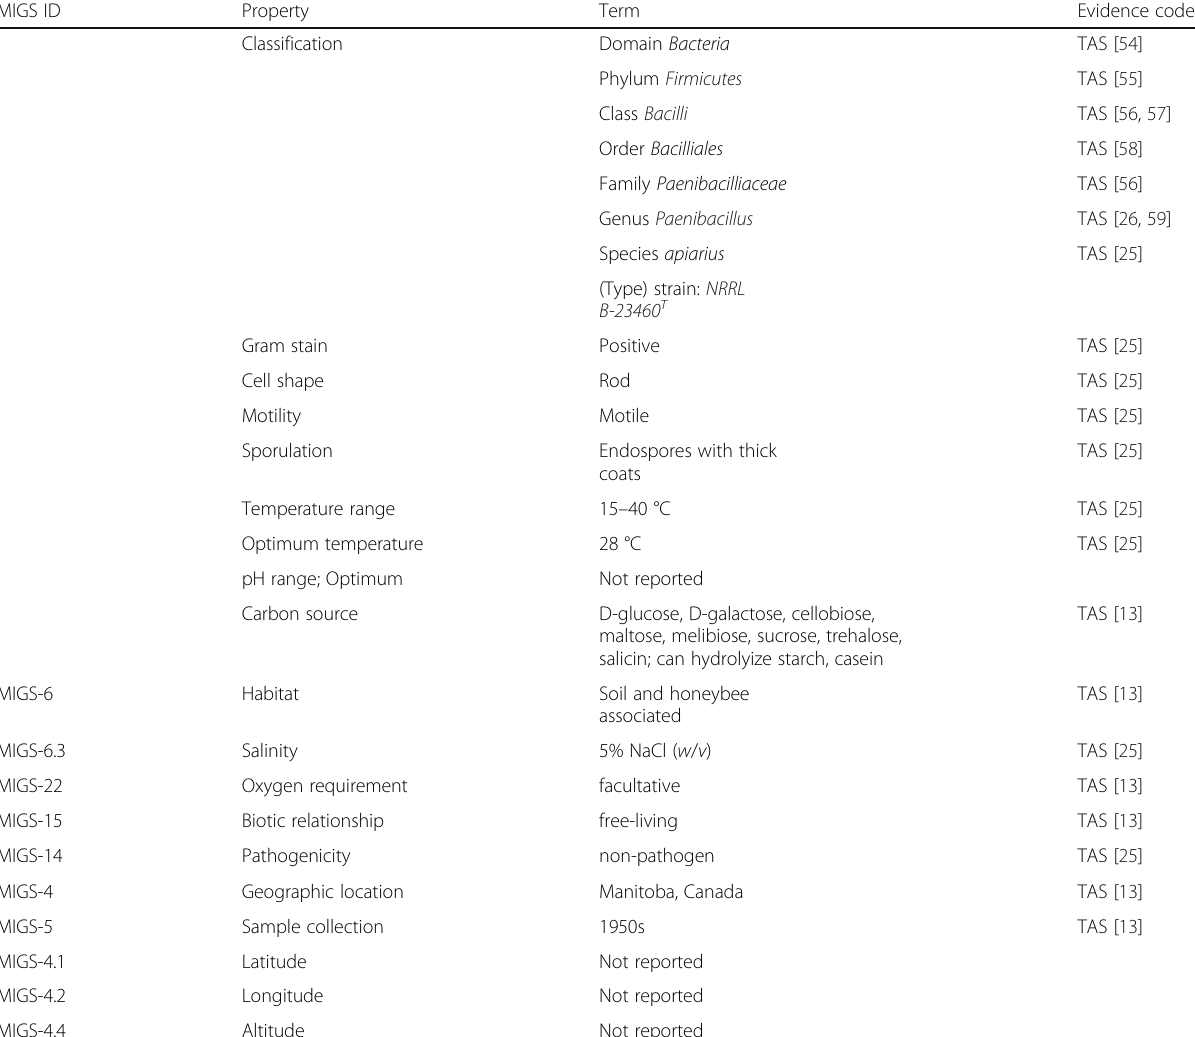
Table 1 Classification and general features of P. apiarius NRRL B-23460 [53] MIGS